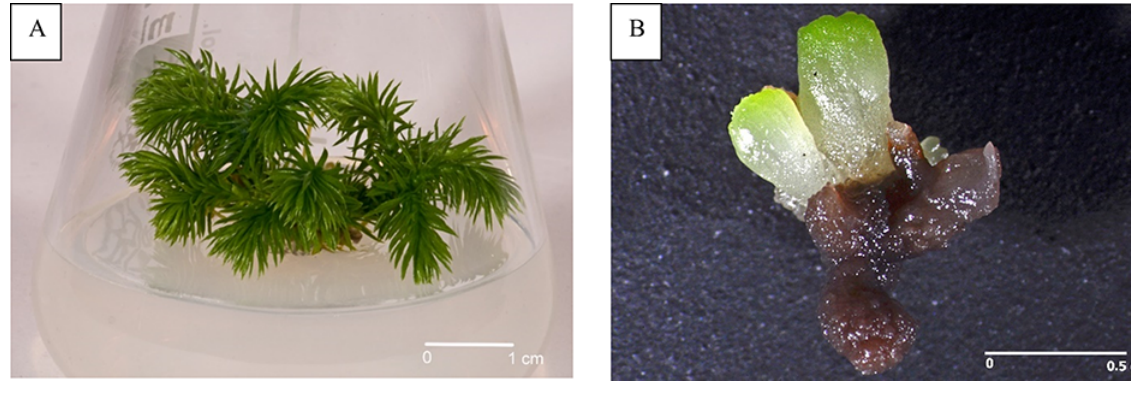
Figure 2 Huperzia selago ( A ) sporophyte and ( B ) gametophyte in in vitro culture.